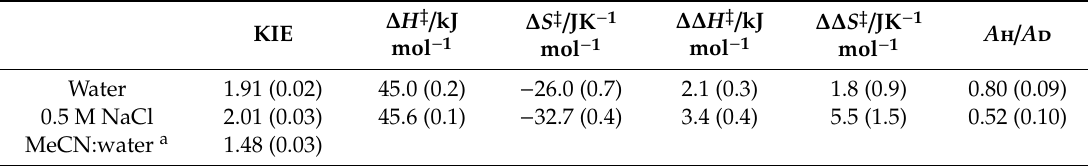
Table 4. Kinetic isotope e ff ects, activation parameters ∆ H ‡ and ∆ S ‡ , isotopic di ff erences ∆∆ H ‡ (D,H) and ∆∆ S ‡ (D,H) and ratios A h / A d in the reaction of ascorbate with ferricinium ion. Adapted from [22]. ∆∆ H ‡ / kJ ∆ H ‡ / kJ ∆∆ S ‡ / JK − 1 ∆ S ‡ / JK − 1 A h / A d KIE mol − 1 mol − 1 mol − 1 mol − 1 Water 1.91 (0.02) 45.0 (0.2) − 26.0